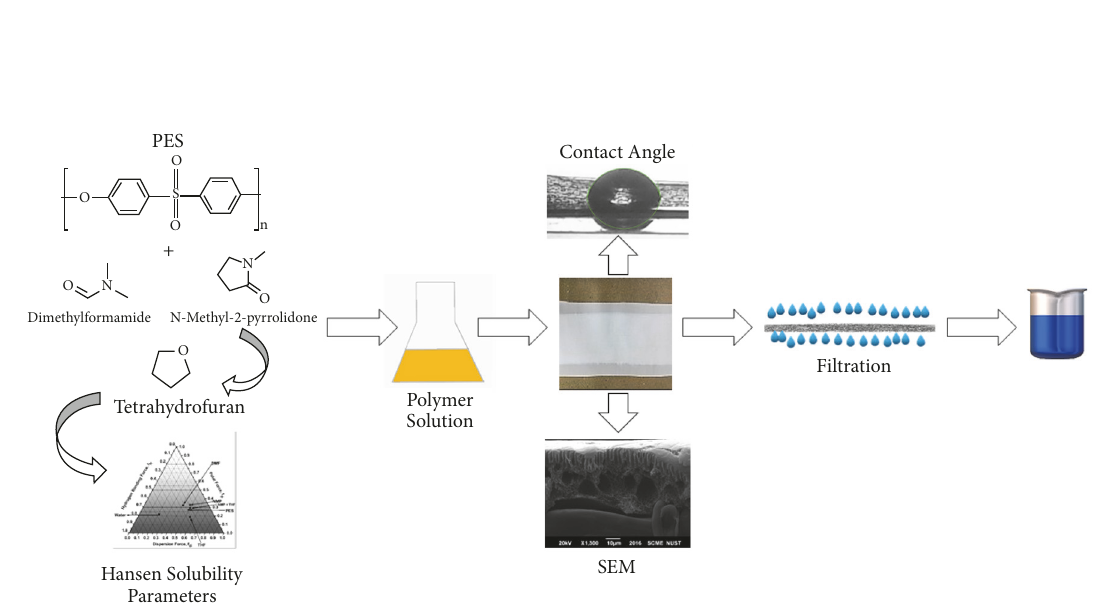
Figure 1: Graphical